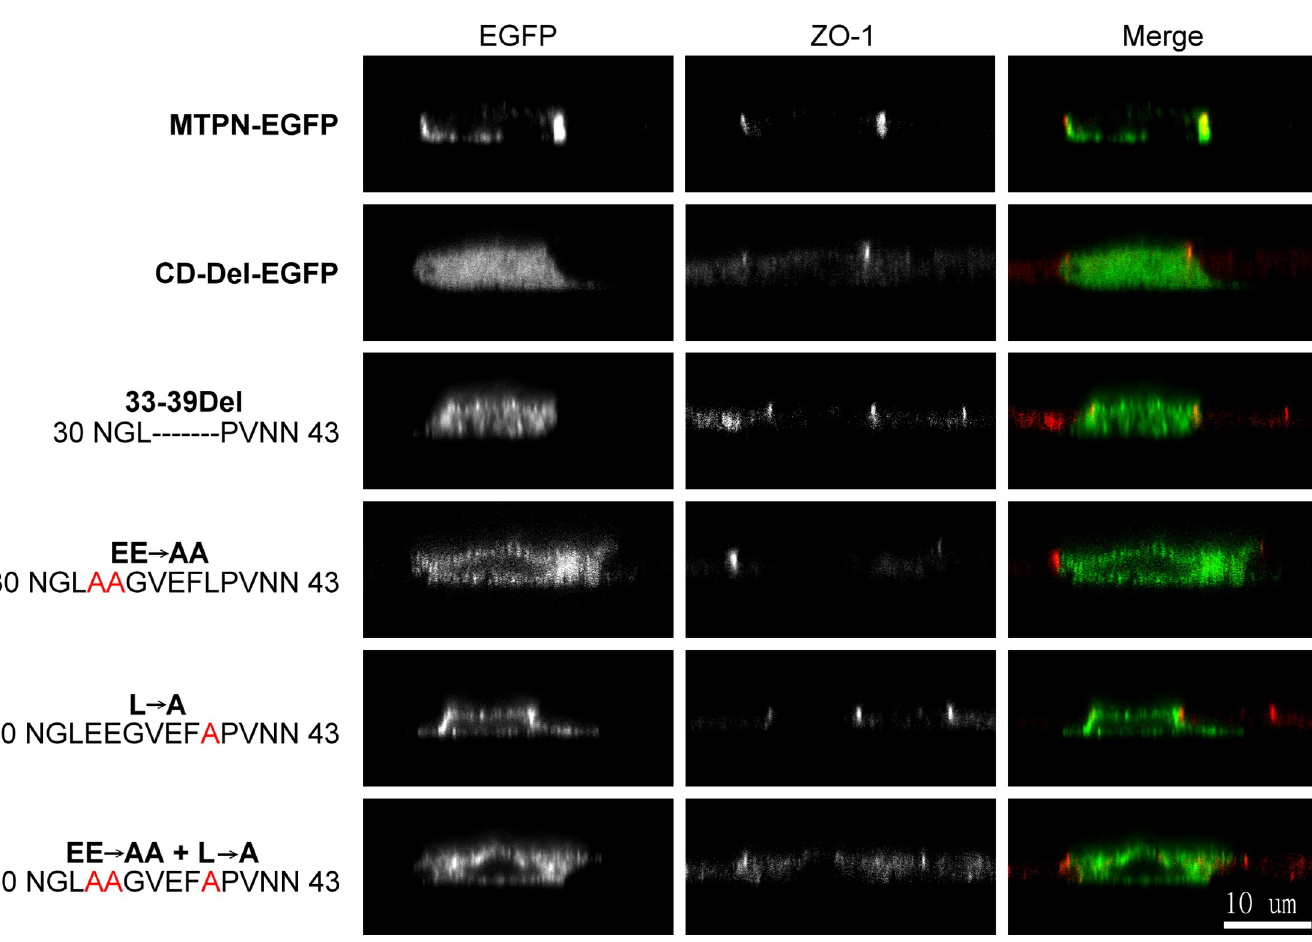
Fig 5. The motif consisting of residues 33–39 with monoleucine C-terminal to acidic cluster contributes to matriptase basolateral sorting. The matriptase-EGFP constructs, including MTPN-EGFP, CD-Del-EGFP, 33-39Del, EE ! AA, L ! A, and EE ! AA + L ! A, as indicated, were transiently expressed in MDCK cells. The subcellular localization and X-Z distribution of these matriptase-EGFP fusion proteins were compared with that of the tight junction marker ZO-1, which was analyzed by indirect immunofluorescent staining using ZO-1 antibody, followed by Alexa 594-labeled anti-mouse IgG. The staining is presented as black and white images (EGFP and ZO-1) and merged false-color images (Merge). Scale bar: 10 μ